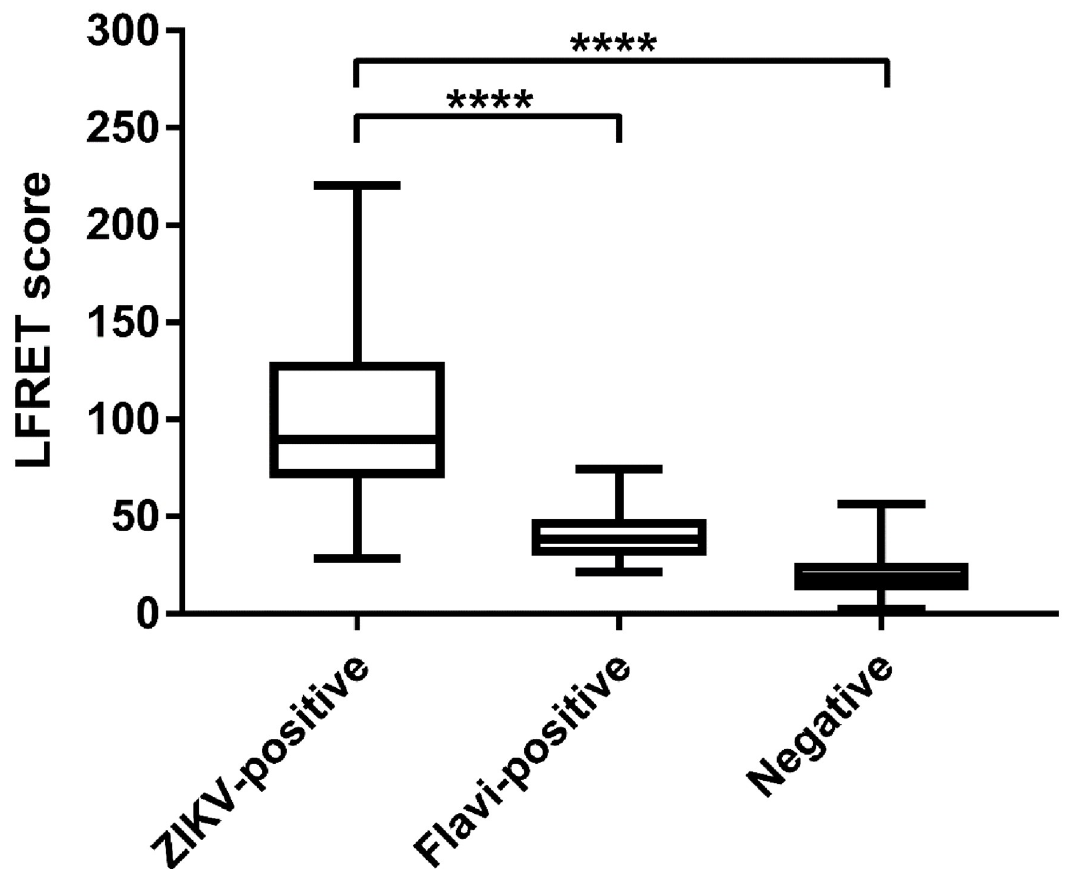
Fig 3. Class-independent LFRET scores measured from the full panel of ZIKV-positive, heterologous flavivirus-positive (DENV, YFV or TBEV) and flavivirus-negative samples.